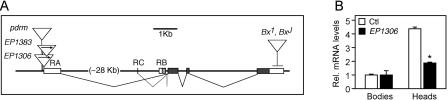
Molecular Structure of the Lmo Locus(A) A genomic map of the Lmo locus. Three different first exons can be utilized, forming the basis for three alternative transcripts. Exon RA-1 is separated from the alternative start sites RB-1 and RC-1 by a large (∼30 kb) intron. EP1306, EP1383, and pdrm carry insertions 25, 73, and 91 bp, respectively, upstream of the exon RA-1 transcriptional start site. Arrows within the EP elements refer to the orientation of the insertion and the expected direction of inducible expression via UAS sites contained within the EP element. Bx alleles are insertions of natural transposons into the 3′ UTR of the Lmo gene that have been shown to stabilize Lmo transcript (Shoresh et al. 1998). Protein-coding exons are shaded.(B) Expression of the Lmo RA transcript is enriched in Drosophila heads, and is reduced in the EP1306 mutant. RNA was isolated from heads and bodies; after cDNA synthesis, quantitative RT-PCR was performed using primers specific to the RA transcript of Lmo in addition to primers to a reference transcript, the ribosomal protein rp49. Relative abundance is expressed as fold increase over control (EP1631) body mRNA. No detectable amplification was seen in RNase-treated controls (data not shown). Error bars represent standard error of the mean. Asterisk denotes significant difference from control (Student's paired t-test assuming equal variance; p < 0.001, n = 3).